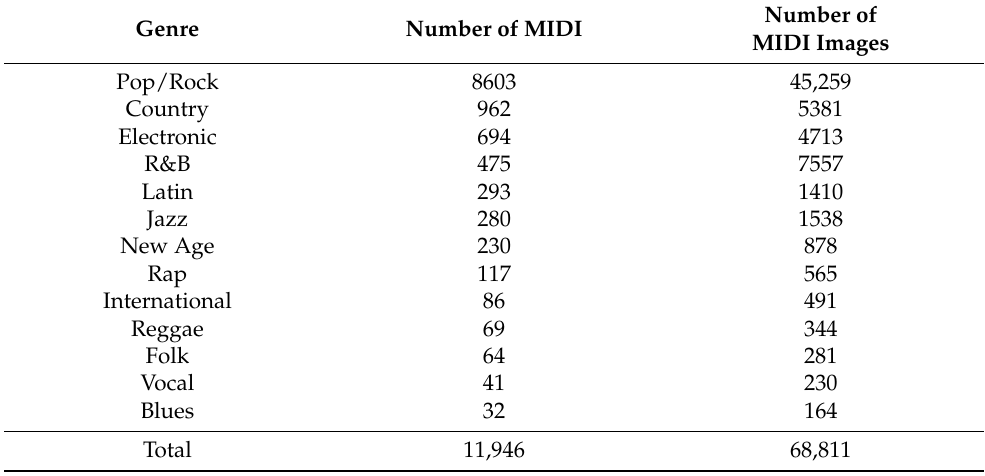
Table 5. The distribution of MIDI with genre labels in the Lakh MIDI